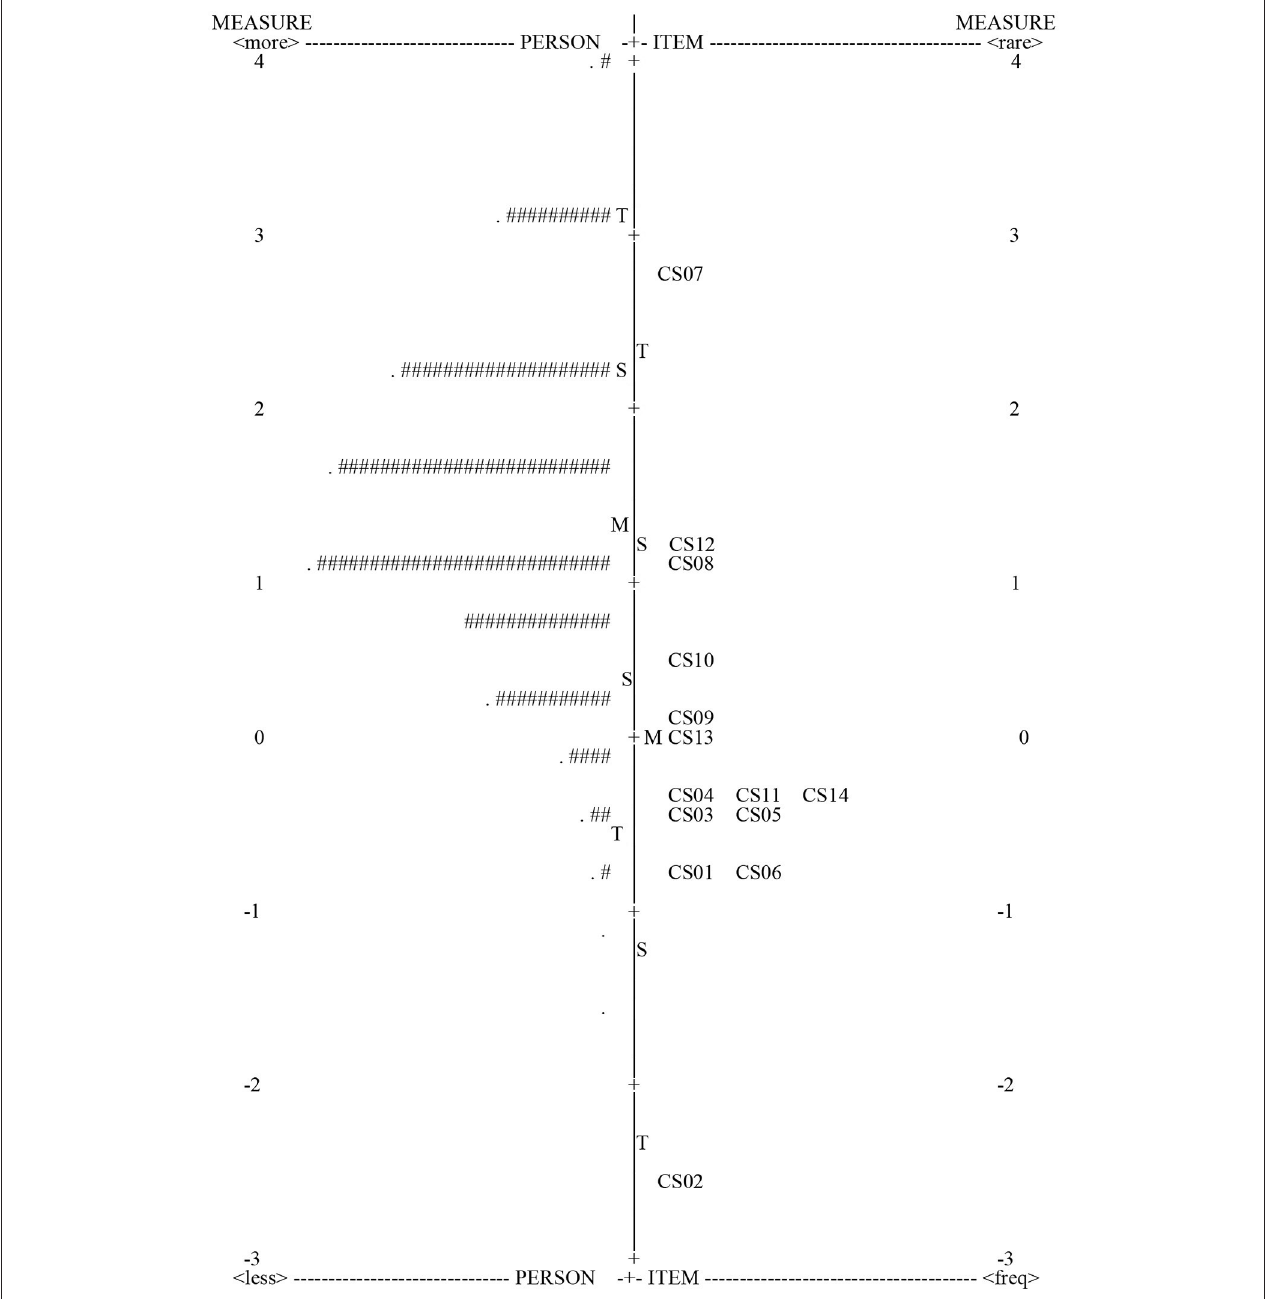
FIGURE 2 | The map of person-item response difficulty locations. Each “#” in the PERSON column is 9 PERSON; each “.” is 1 to 8. + M, item mean; M, person mean; S, 1 SD from the mean; T, 2 SD from the